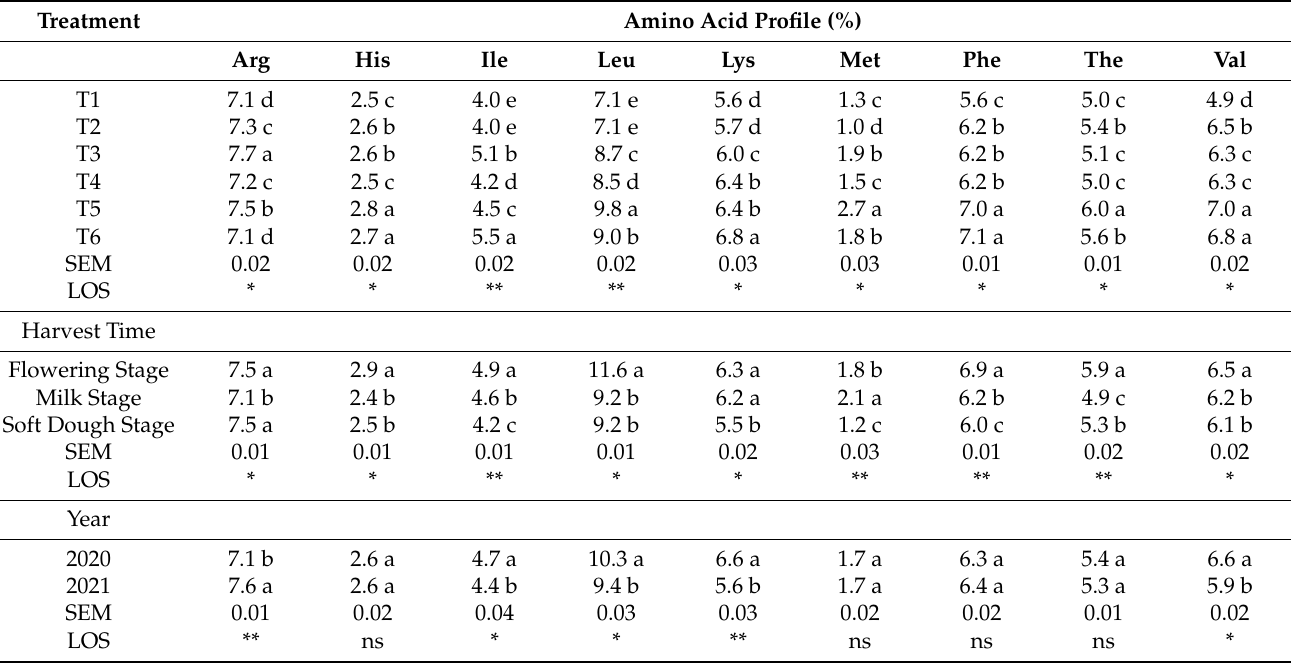
Table 4. Amino acid profile of fresh forage and hay of wheat and ryegrass sole-cropped and mixed with alfalfa harvested at different maturity stages